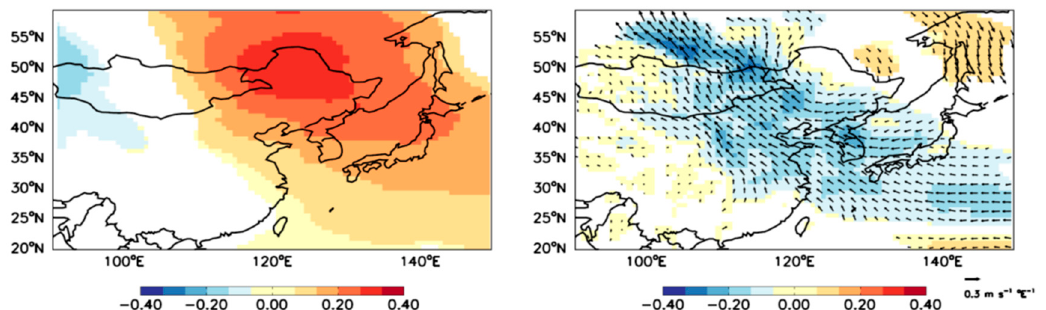
Figure 8. Regressed ( a ) sea level pressure (left panel) and ( b ) wind (shading: wind speed; vector: wind; right panel) at 850 hPa against the longitudinal center of the Siberian High for 1979–2017. The shading and vector only are plotted at the 90% confidence level. Units are hPa ◦ E − 1 and m s − 1 ◦ E − 1 , respectively.